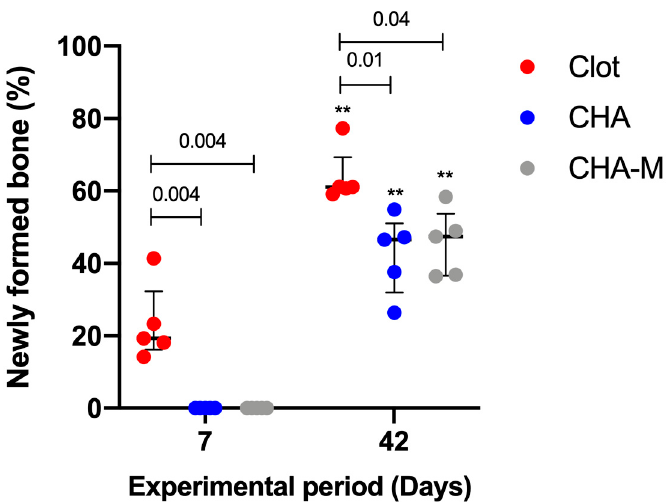
Figure 5. Percentage of newly formed bone of all groups after 7 and 42 days after grafting. Results are presented as a median and IQR ( n = 5). Kruskal–Wallis and Dunn’s post-test were applied to investigate differences between the groups at the same time point. Mann–Whitney test was used to evaluate differences between the same experimental group in different time points. The (**, p = 0.007) represents statistical difference between the same group in different experimental periods. The horizontal bar represents statistical differences between groups over the same period.